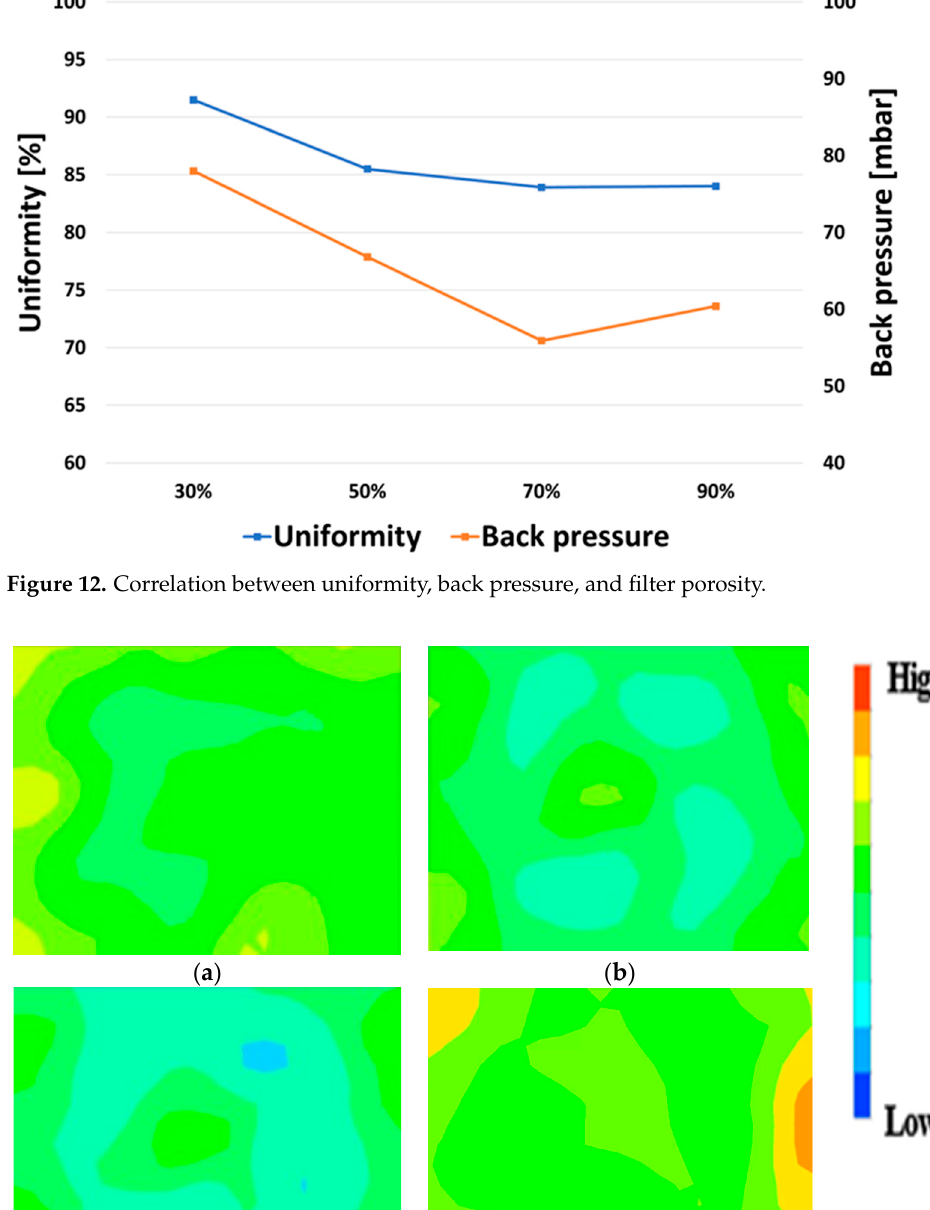
Figure 12. Correlation between uniformity, back pressure, and filter porosity.